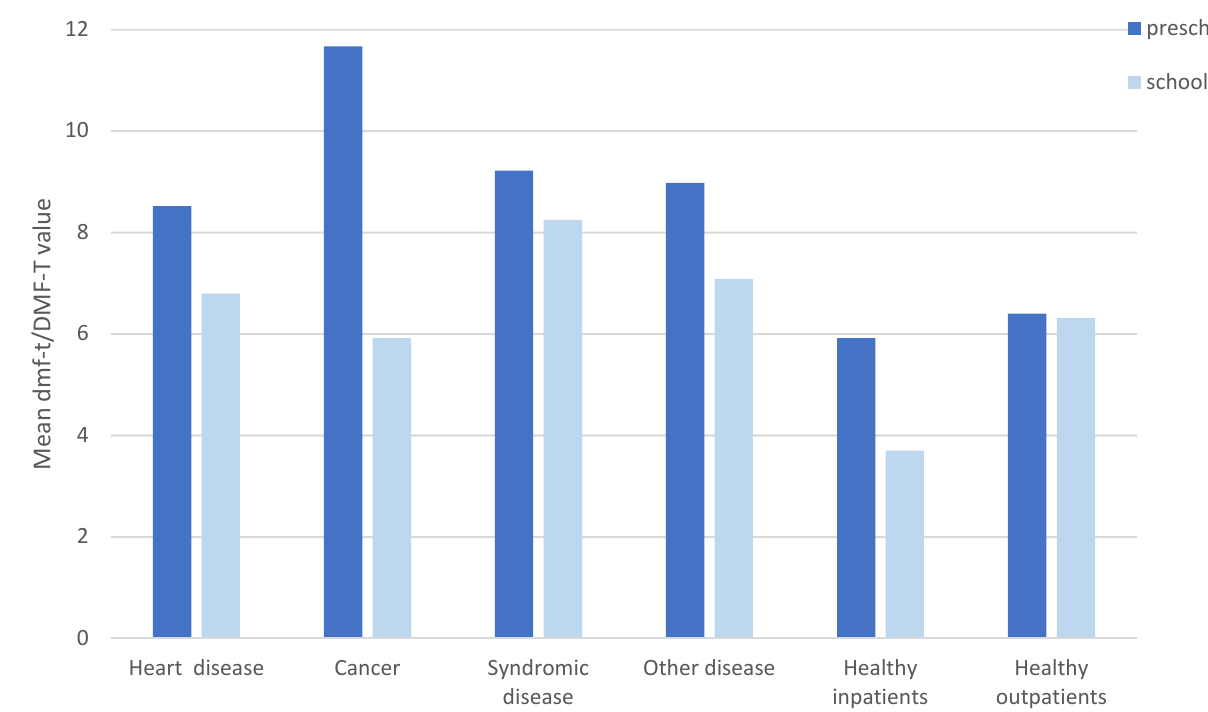
Figure 1. Mean dmf-t/DMF-T values in the different groups at impulse 1.